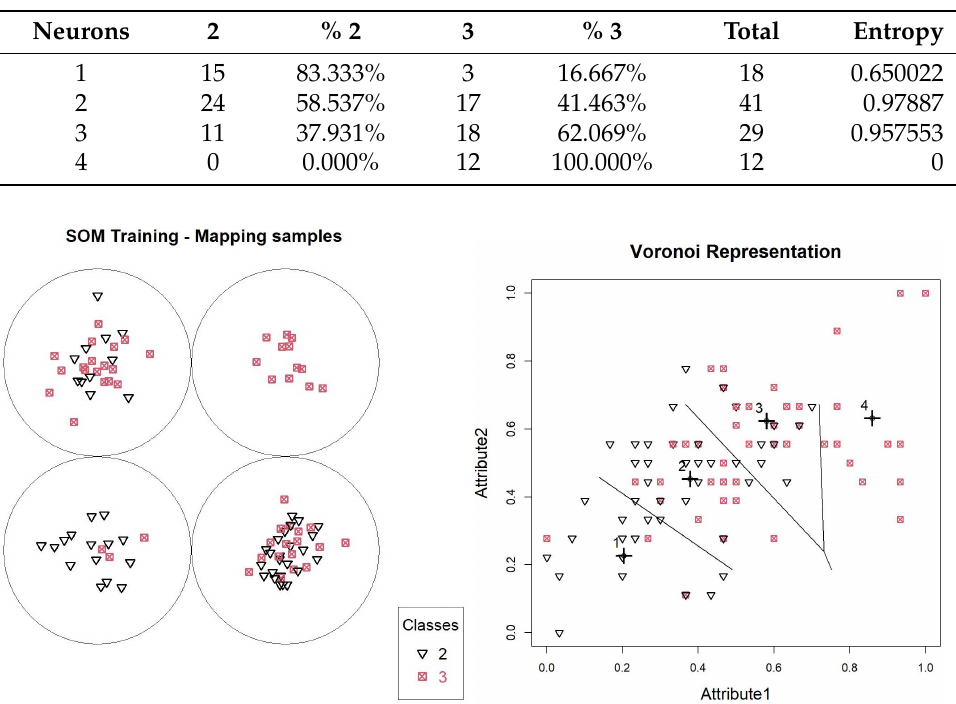
Table 1. Entropies and numbers of objects—level 1.